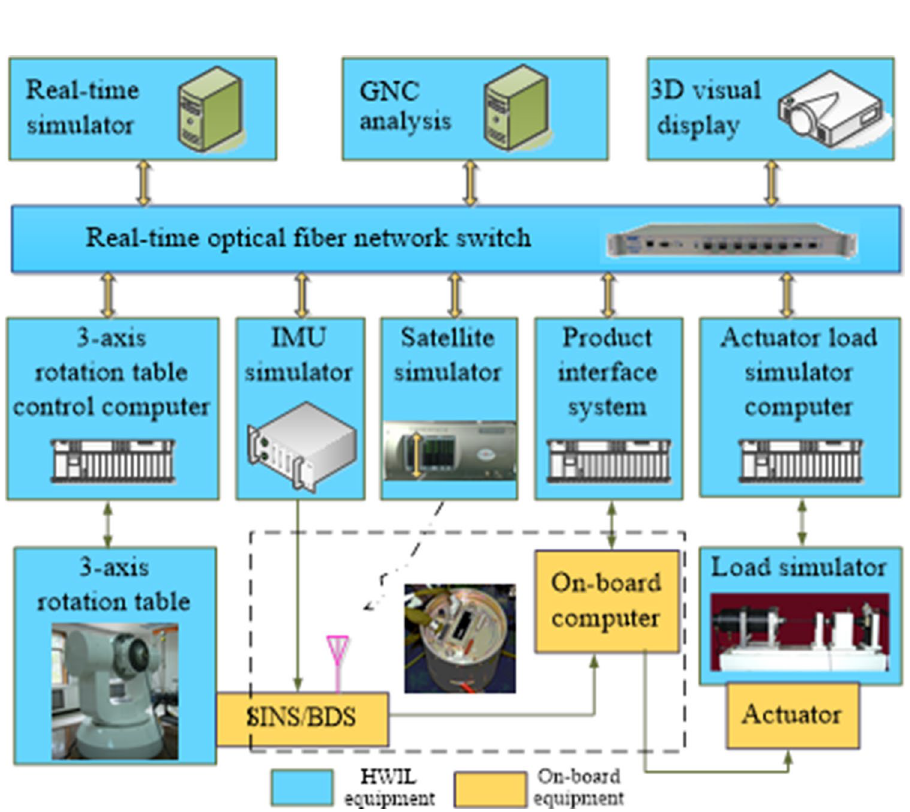
Figure 14. Diagram of HWIL simulation system for hypersonic vehicle